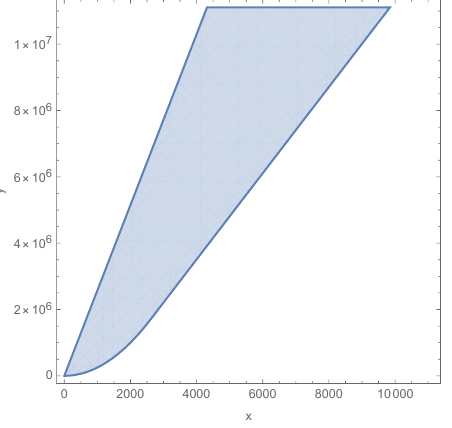
Figure 6 . The allowed region satisfying h a 4 , i, i +1 i > 0 . We have plotted the combined constraint for i ≤ 40 . For larger i s, the constraint does not appear for the range of ( x, y ) displayed in the